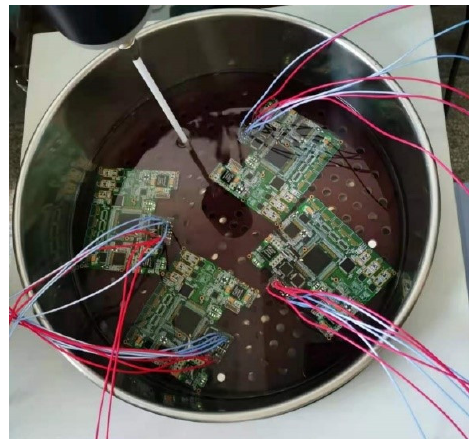
Figure 2. Samples in the oil bath heater.